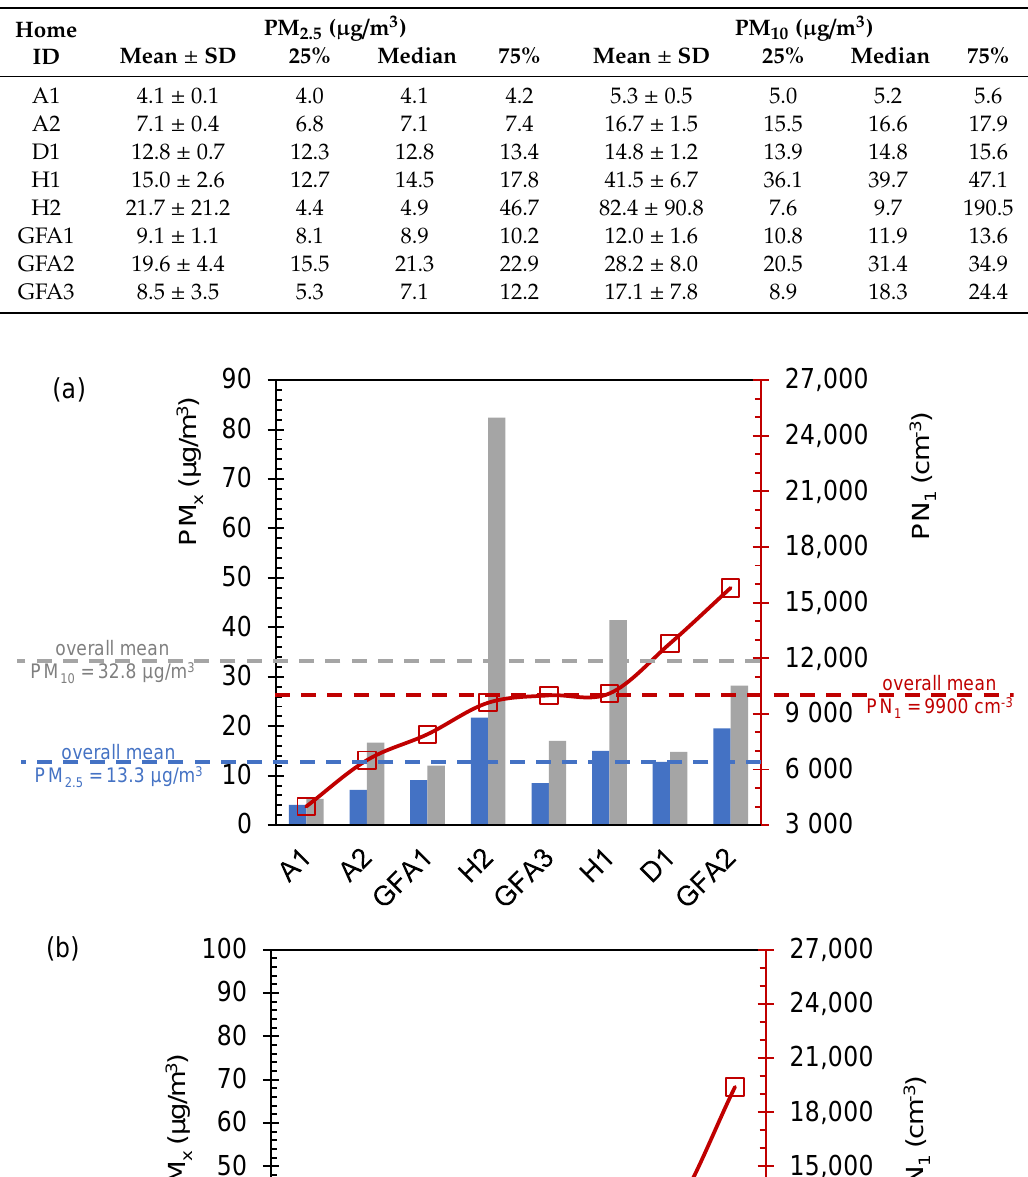
Table 2. Mean indoor particle mass concentrations in Jordanian homes during background periods. Home(chenchen)